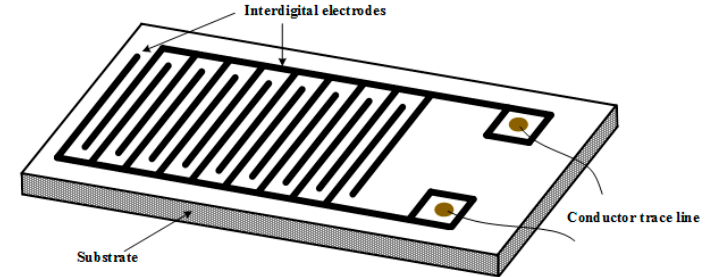
Figure 7. Geometrical morphology of film sensor.